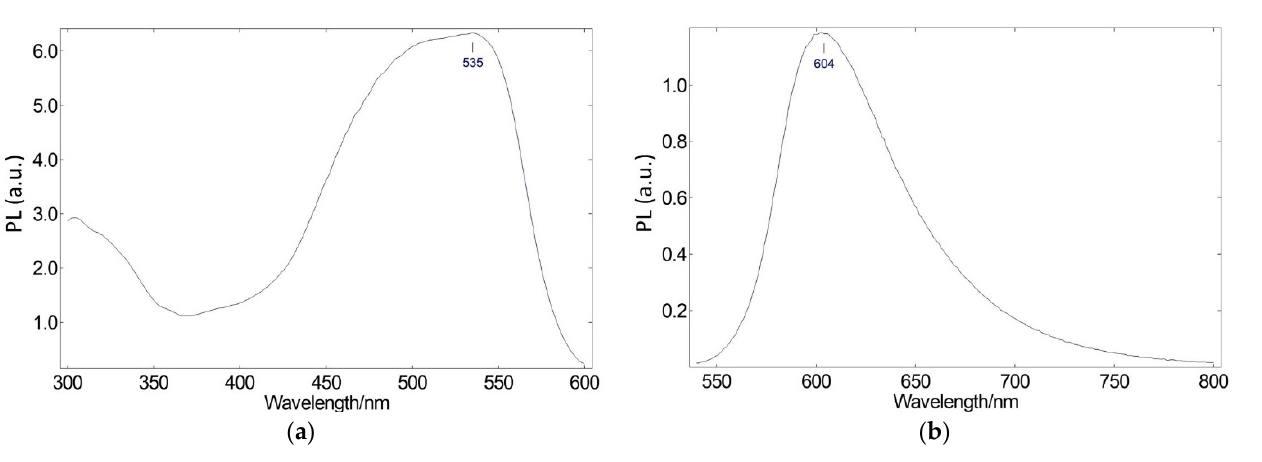
Figure 8. ( a ) Photoluminescence excitation spectrum (peaking at 535 nm) and ( b ) photoluminescence emission spectrum (peaking at 604 nm) of Nile Red red-emitting converter embedded in an EVA polymer.